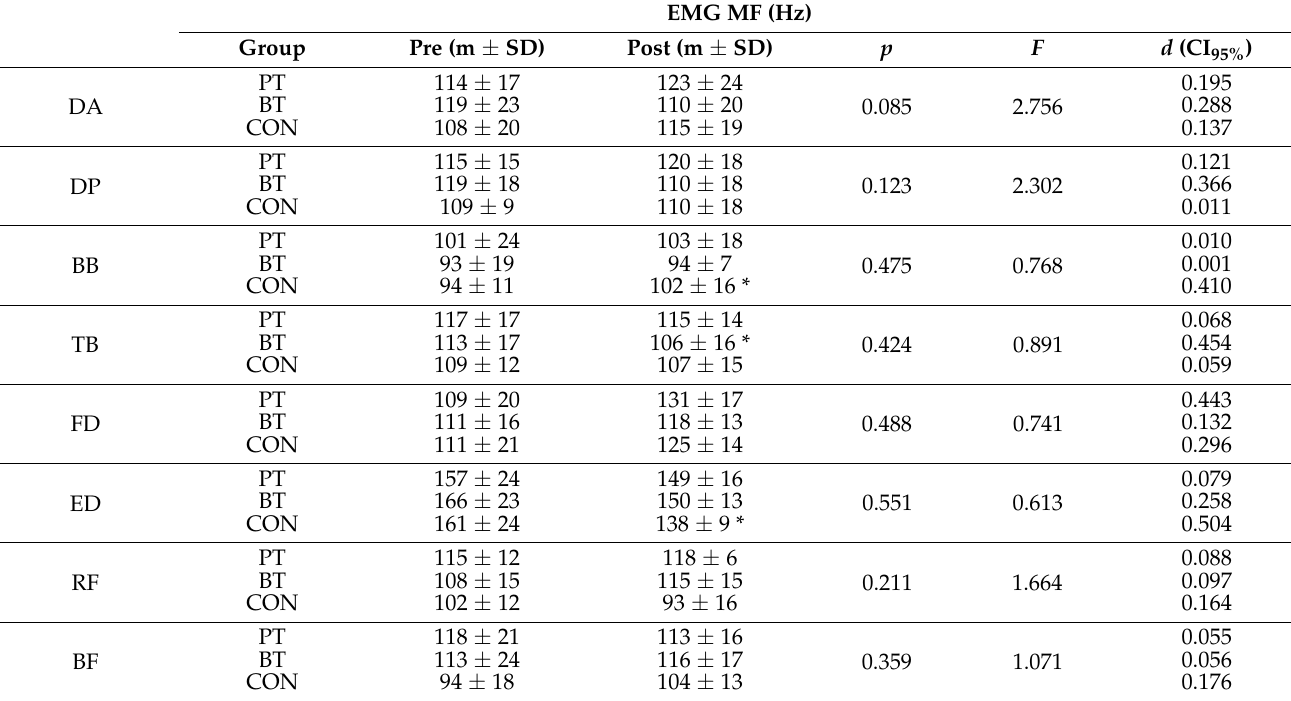
Table 7. Changes in the EMG mean frequency (MF) in each muscle during the stroke test after the 8-week